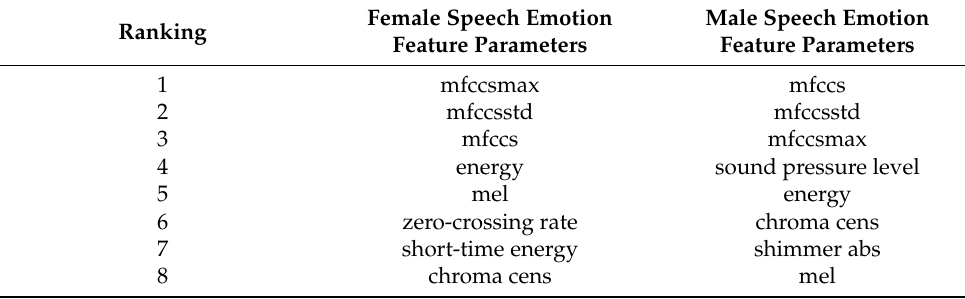
Table 1. Ranking of male and female speech emotion feature parameters. Female Speech Emotion Ranking Feature Parameters